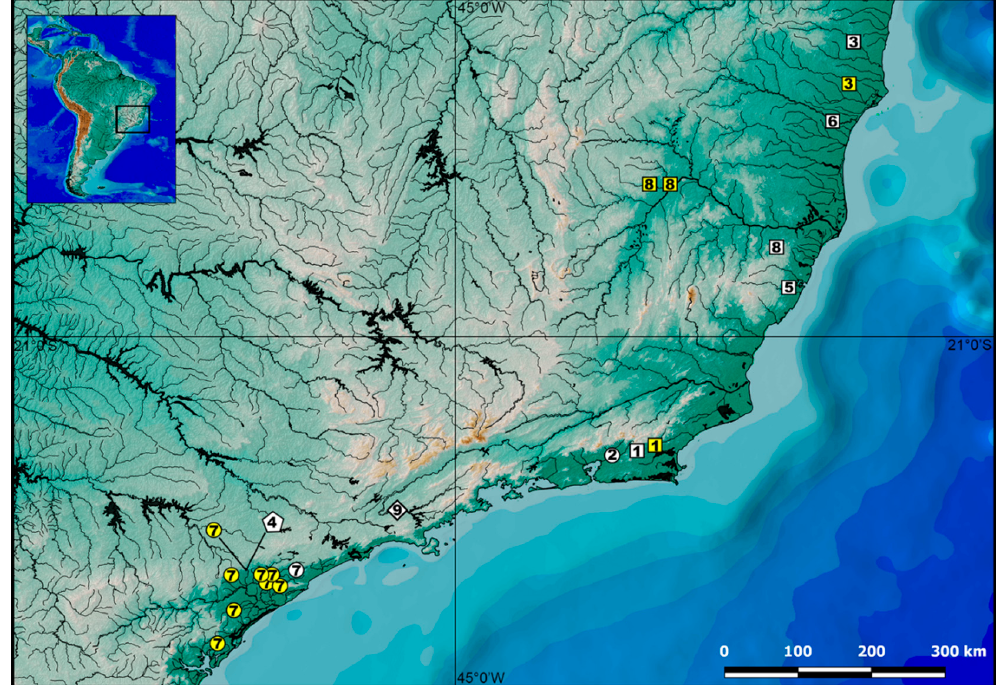
Figure 3. Geographical distribution of species of the genus Microcambeva and the incertae sedis microcambevine Pygidium triguttatum (lozenge). Circles indicate species of the subgenus Pterocambeva ; squares, species of the subgenus Microcambeva ; and pentagon, species of the subgenus Trichocambeva . 1, M. barbata ; 2, M. bendego ; 3, M. draco ; 4, M. filamentosa ; 5, M. jucuensis ; 6, M. mucuriensis ; 7, M. ribeirae ; 8, M. watu ; 9, P. triguttatum . White symbols are type